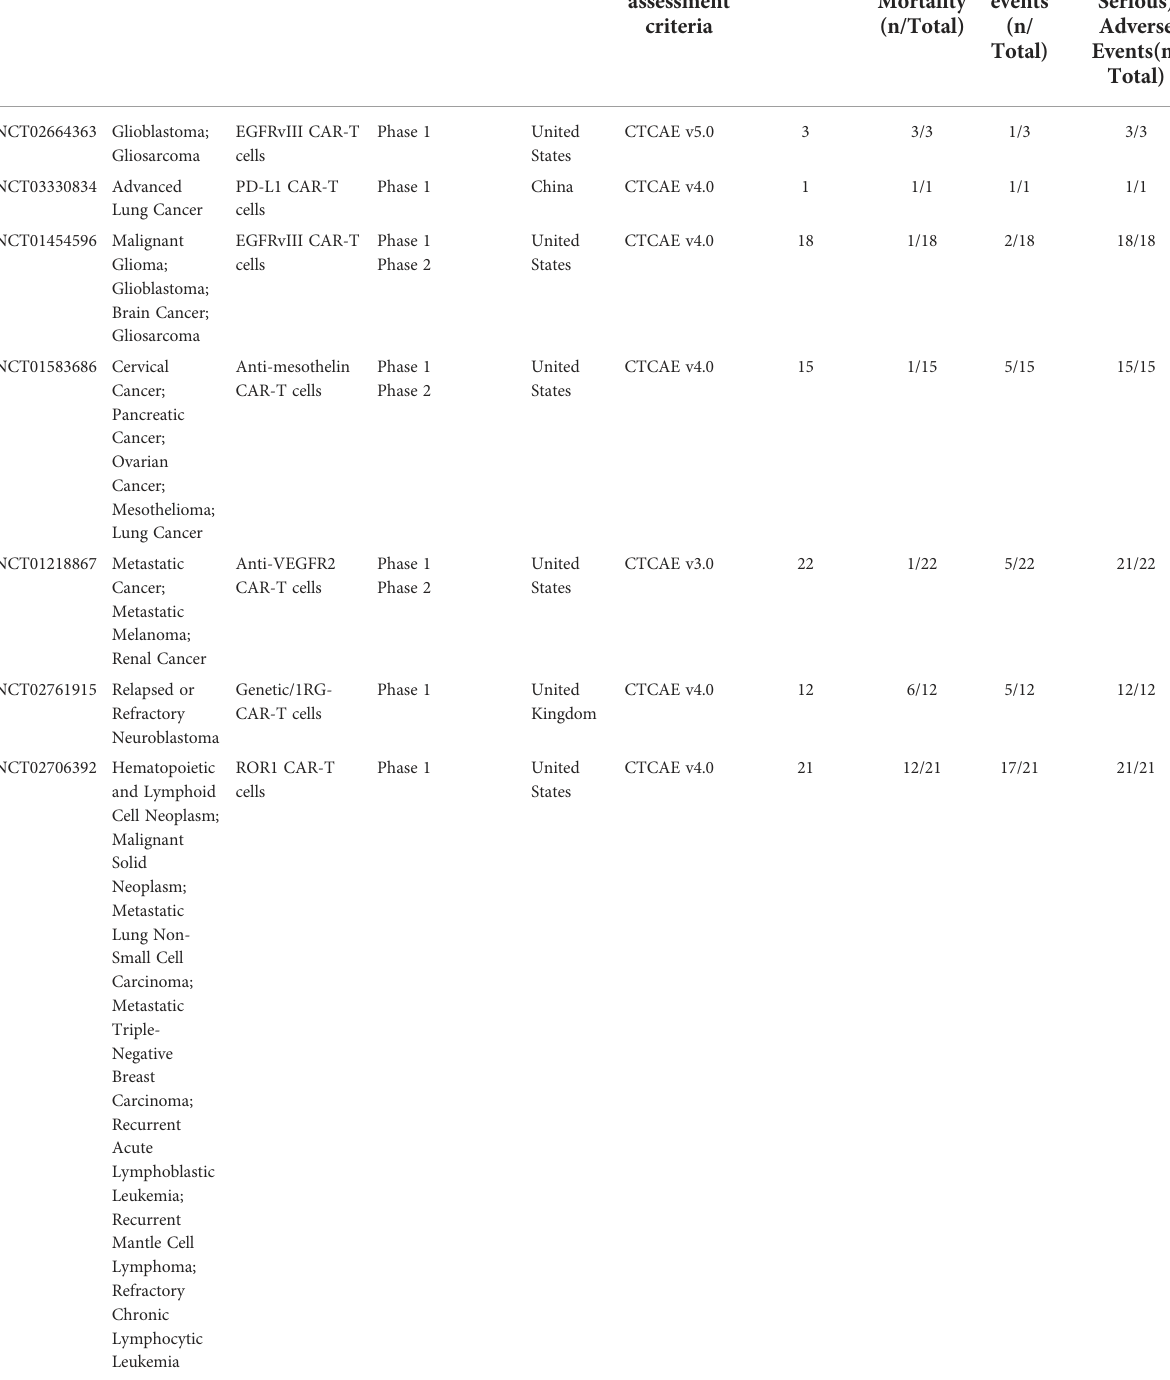
TABLE 3 The incidence of clinical serious adverse events of CAR-T in solid